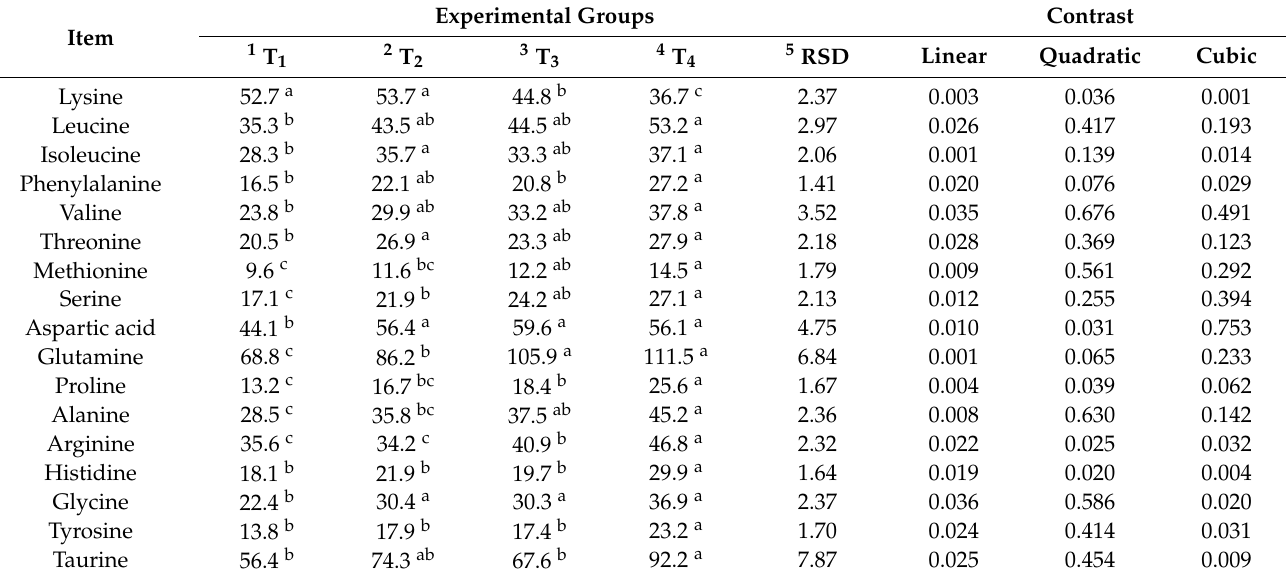
Table 3. Effect of dietary supplementation with GA on the amino acid profile (g 100 g − 1 ) of the thigh muscles in laying hens. Experimental Groups Item